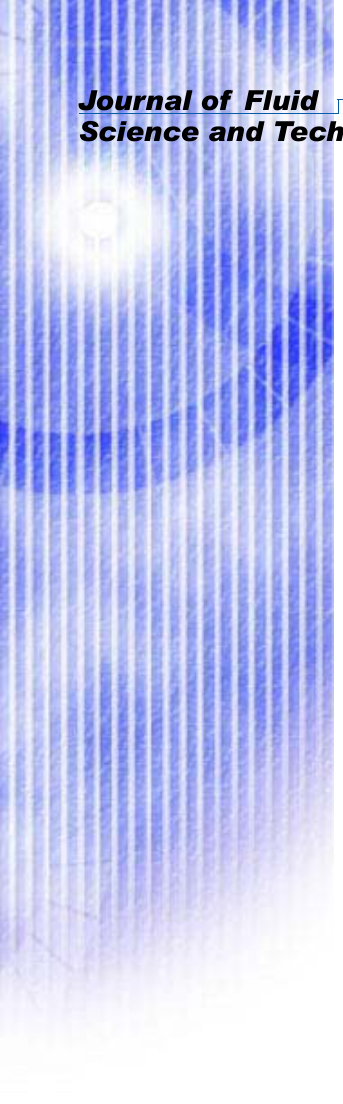
As seen in the region near the wall and blades (R=130mm, Z=30-60mm), however, the flow towards the wall of the mixer is much more dominant in the flat blade than in the beveled blade. In the flat blade, it is clear that the particles collide with the wall of mixer. In the beveled blade, there is little region where the particles collides with the wall of mixer except Z=30-40mm.The upwards flow is dominant at Z=40-100mm. There is less